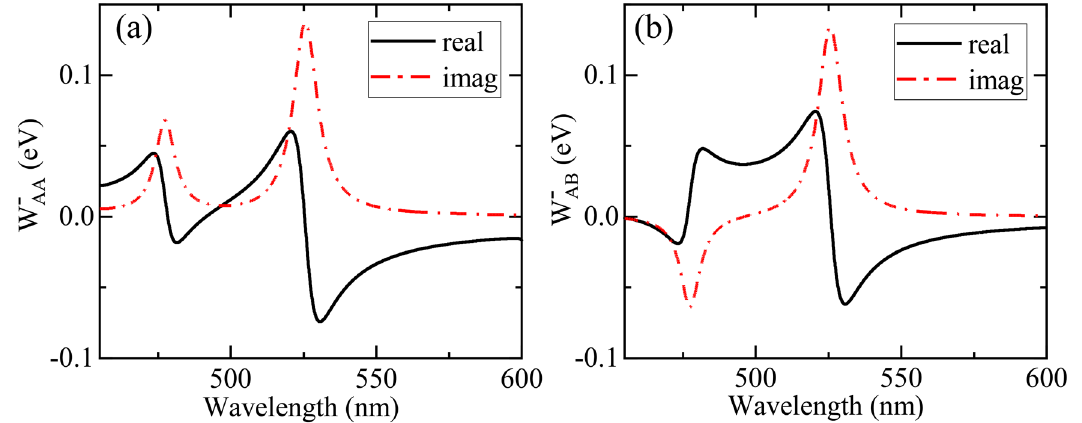
i Ŵ AA (�) � AA (�) 2 and = + (cid:31)